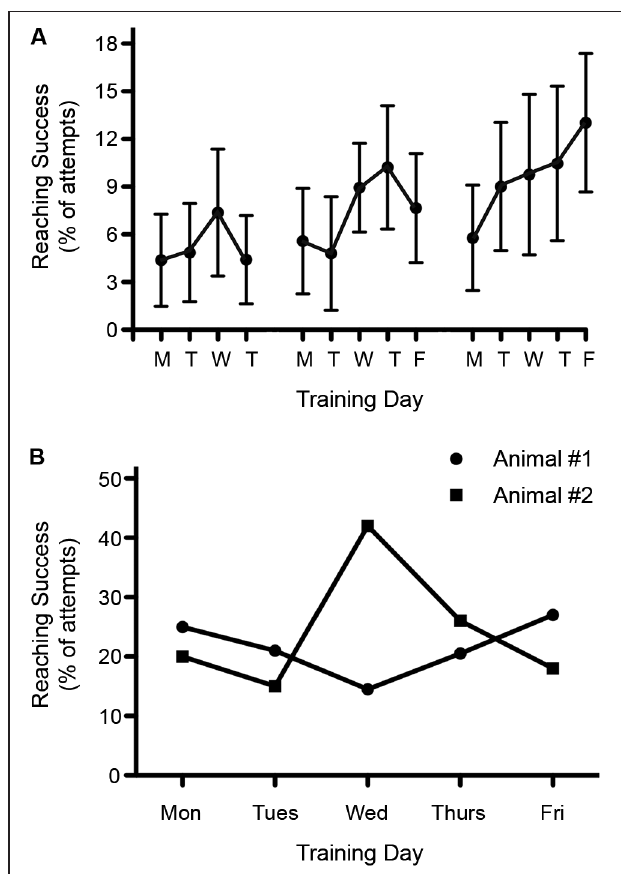
FIGURE 5 | Variability in reaching success throughoutthe week . (A) Reaching recovery was assessed following a C4 dorsolateral quadrant spinal cord lesion. Success during rehabilitative training was found to be lowest on Mondays. Data is shown as mean ± SEM, n = 10. (B) Reaching success varied throughout the week among individual rats. Graph shows the pre-injury reaching performance for two different rats over the course of one